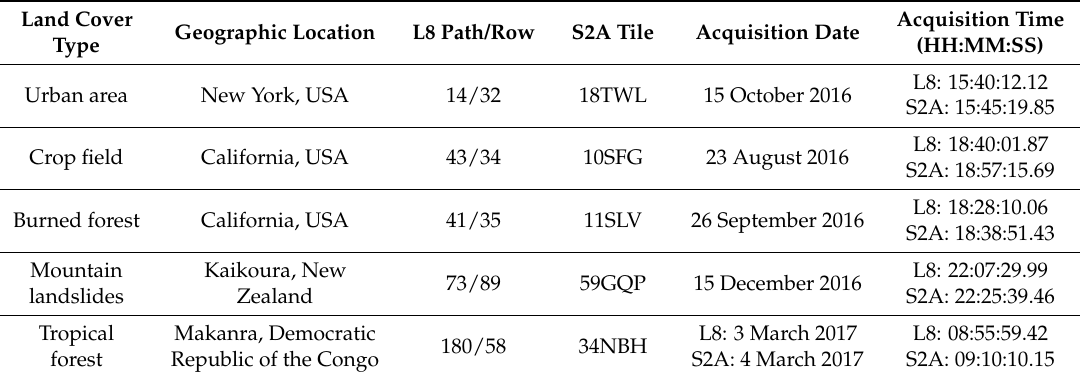
Table 2. Landsat-8 (L8) and Sentinel-2A (S2A) study